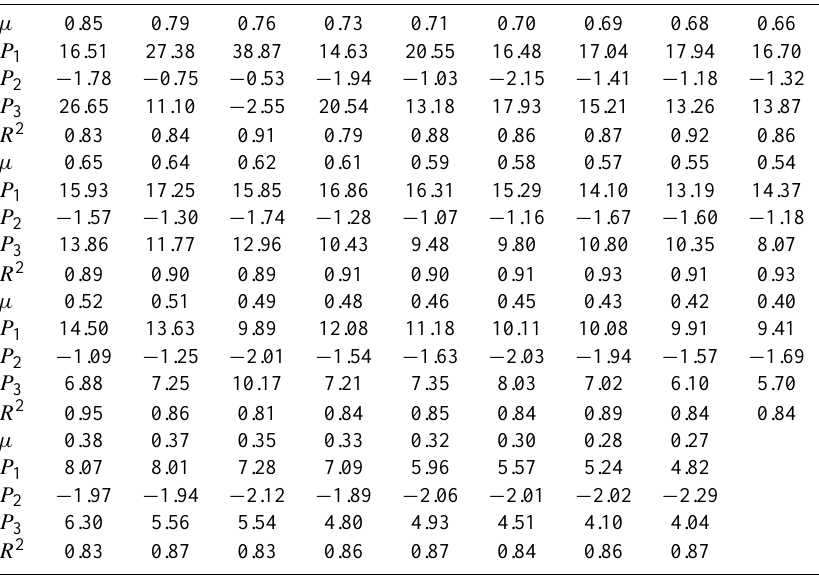
Table 2. The parameters of Eq. (1): P 1 (Wm − 2 ) , P 2 and P 3 (Wm − 2 ) derived from the least-squares fitting of UV and τ 500nm for narrow ranges of solar zenith angle. R 2 represents the coefficient of